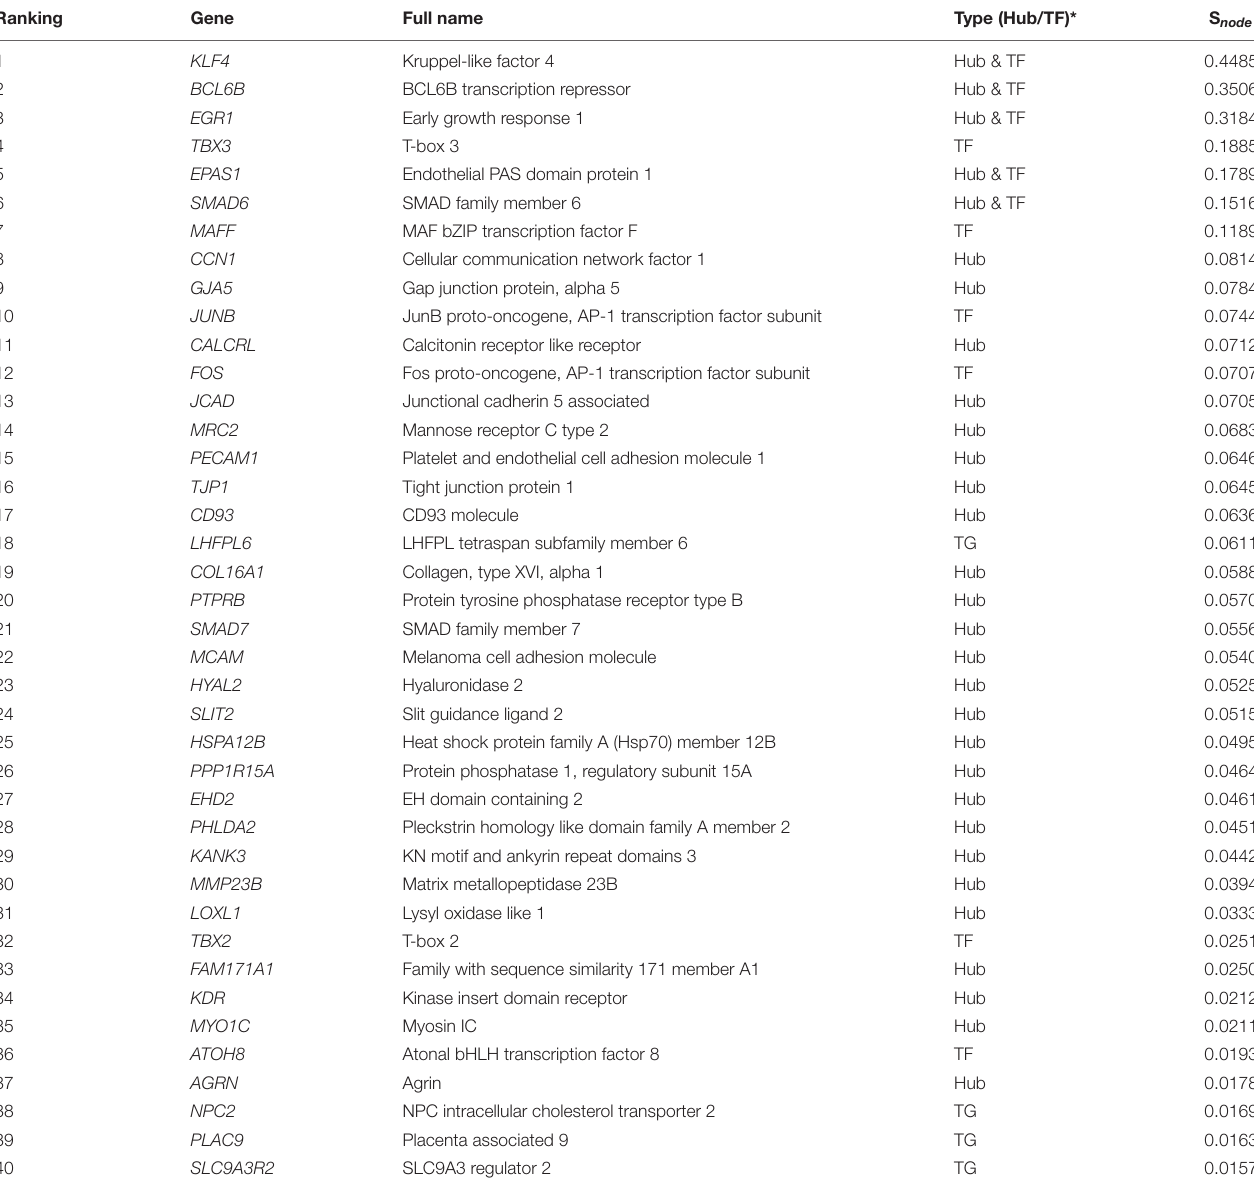
TABLE 6 | The top 25% of S node genes in the Tibetan pig lung gene regulatory network. Ranking